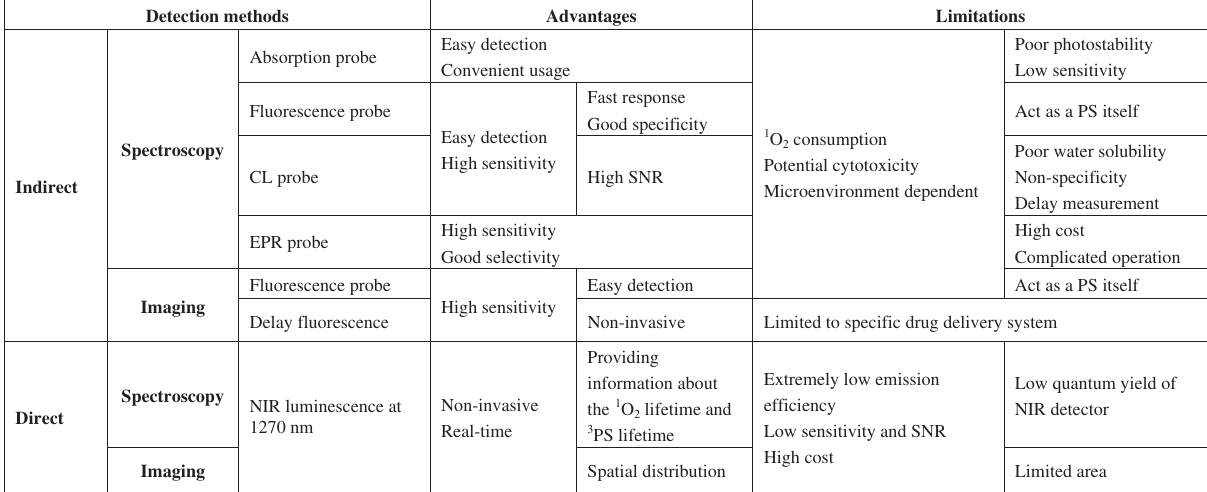
Table 1. Advantages and limitations of the currently available methods for 1 O 2 detection.